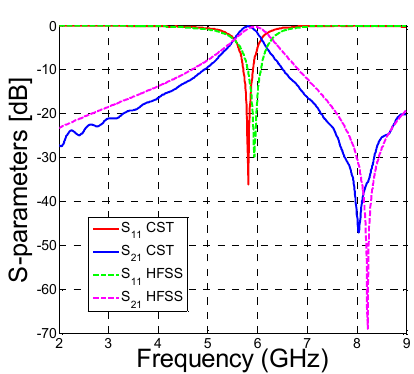
FIGURE 4. Simulated S-parameters of the C-HMC loaded SIW filter.